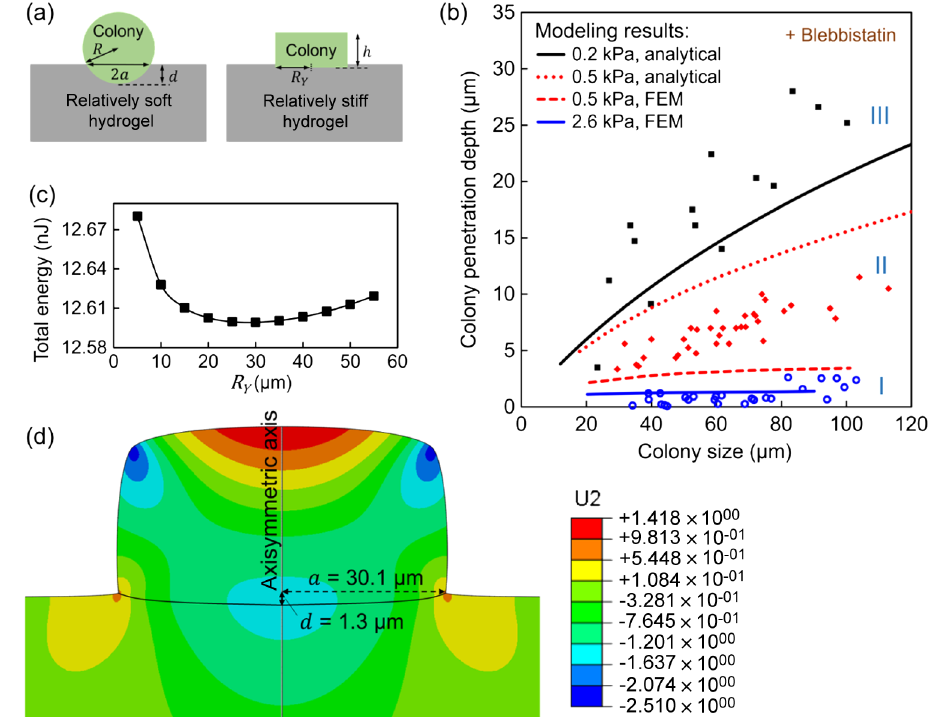
FIG. 4. Modeling of colony indentation driven by interfacial stresses. (a) Schematic of the colony configurations in adhesive contact with a relatively soft hydrogel (left) and a relatively stiff hydrogel (right). For the relatively soft hydrogel, the colony is assumed to be a sphere with a radius R , dimpling depth d , and contact radius a . For the relatively stiff hydrogel, the colony is assumed to be a cylinder with a constant colony volume V C , where V C ¼ π R 2 Y h with a variable radius R Y and a variable height h . (b) Colony dimpling from the modeling results (curves) versus experiments (dots). Colony size is denoted as the equivalent diameter determined by D ¼ ð 4 S= π Þ 1 = 2 , where S is the colony area. Black, red, and blue dots are 0.2, 0.5, and 2.6 kPa experimental results from Fig. 2(a), respectively, in the presence of blebbistatin. Three regimes are denoted based on the critical elastocapillary length in comparison to the cell colony size. The computational model is suited for regime I and provides the lower bound of regime II. The analytical model is suited for regime III and provides the upper bound of regime II. (c) The total energy, determined by FEM, stored in the system as a function of contact radius R Y to identify the actual contact radius that minimizes the total system energy. (d) Contour of vertical displacement (U2) for the deformed colony and hydrogel. The colony volume is fixed as 8 . 5 × 10 4 μ m 3 , and contact radius is 30 . 1 μ m in the reference